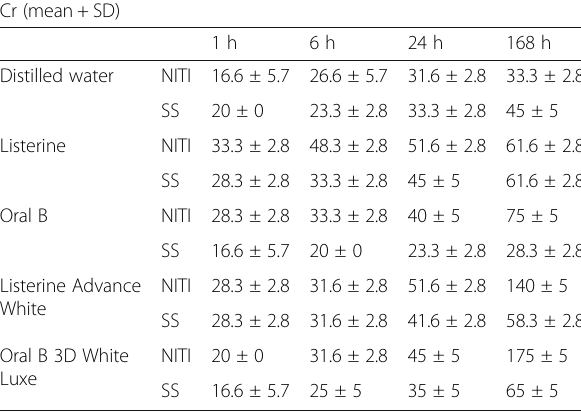
Table 7 Release of chromium ions from NiTi and SS wires at various